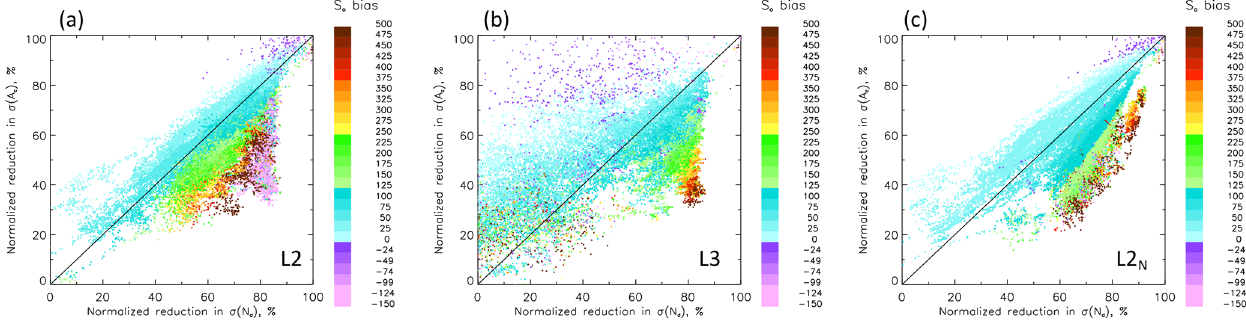
Figure 9. As in Fig. 7 but with points colored by S o bias. Biases exceeding 100% always occur when averaging-related smoothing has a stronger effect on N d than on A c